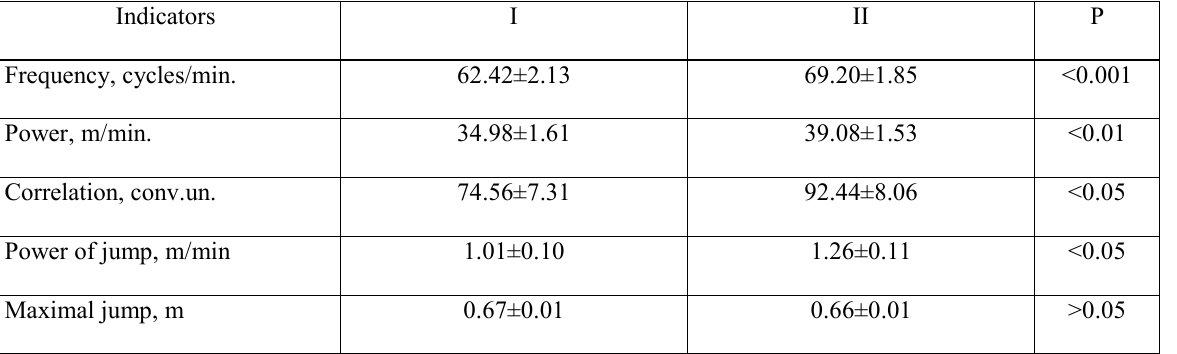
Indicators of physical workability in 60 seconds’ test with and without (I)and with biological feedback (II) (n = 23) Indicators І ІІ Р Frequency, cycles/min. Power, m/min.